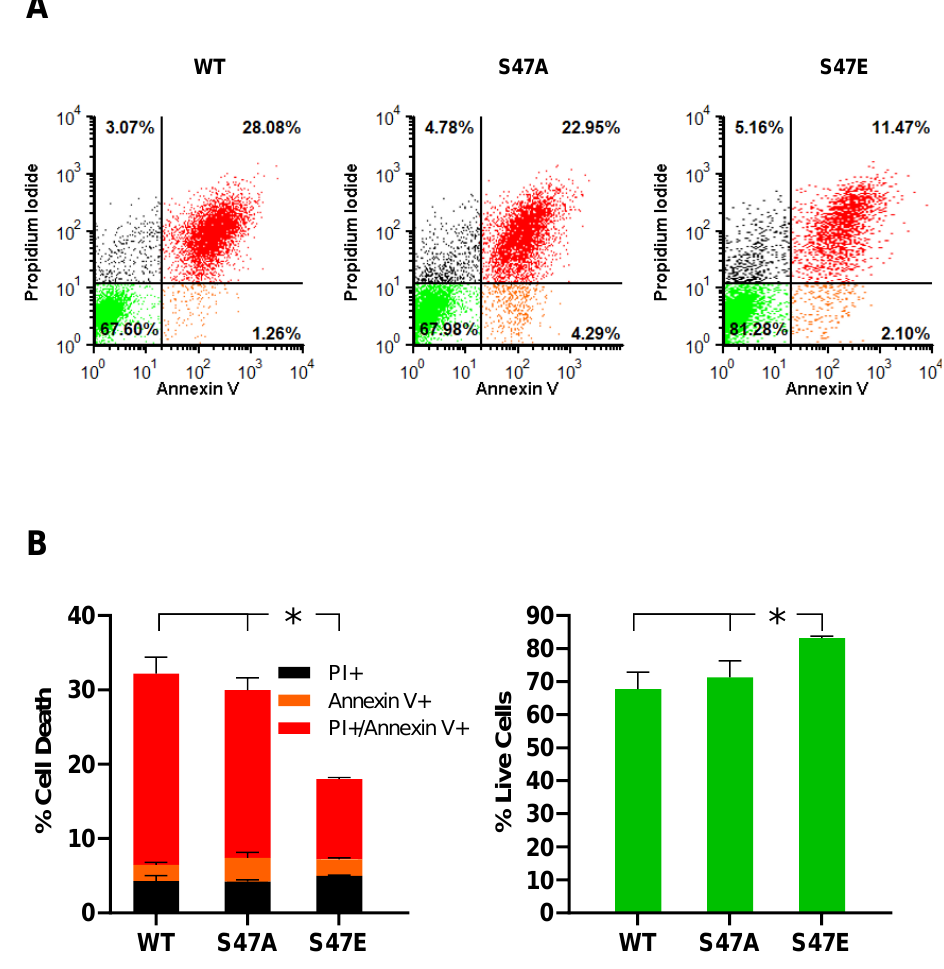
Figure 4. ( A ) Flow cytometry scatter plots representing necrotic (black, positive only for propidium iodide), early apoptotic (orange, positive only for annexin V), late apoptotic (red, double-positive for propidium iodide and annexin V), and live cells (green, unstained) in WT, S47A, S47E Cyt c expressing cells following exposure to oxygen-glucose deprivation for 12 h, followed by reoxygenation for 1 h. ( B ) Cell death represented as fractions of necrotic (black), early apoptotic (orange), and late apoptotic (red) cells. Live cells, represented in the lower left quadrant in the flow cytometry scatter plots, are shown as percent of total cells. The empty vector cell line was excluded due to near-complete cell death in the absence of glucose ( n = 3–4). Data are represented as means ± SEM, * p < 0.05.